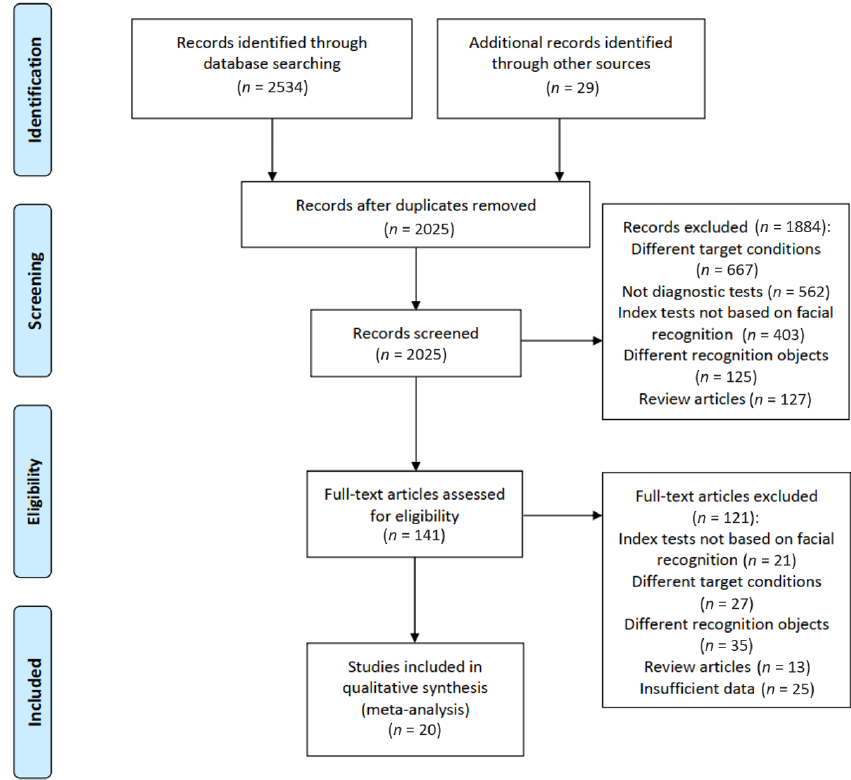
Figure 1. Flow chart for study inclusion and exclusion. The titles and the abstracts were screened by two reviewers independently, and the full texts of potentially eligible studies were further screened.